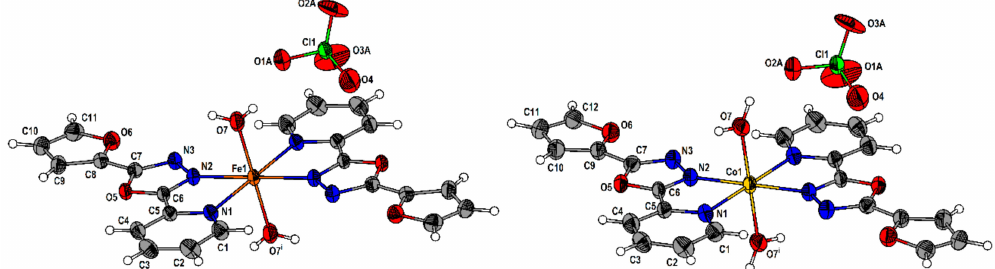
Figure 1. The molecular structures of [Fe(fpo) 2 (H 2 O) 2 ](ClO 4 ) 2 (1, left) and [Co(fpo) 2 (H 2 O) 2 ](ClO 4 ) 2 (2, right). The most populated part of the perchlorate anion is depicted. Symmetrical codes: i: 1-x, 1-y,